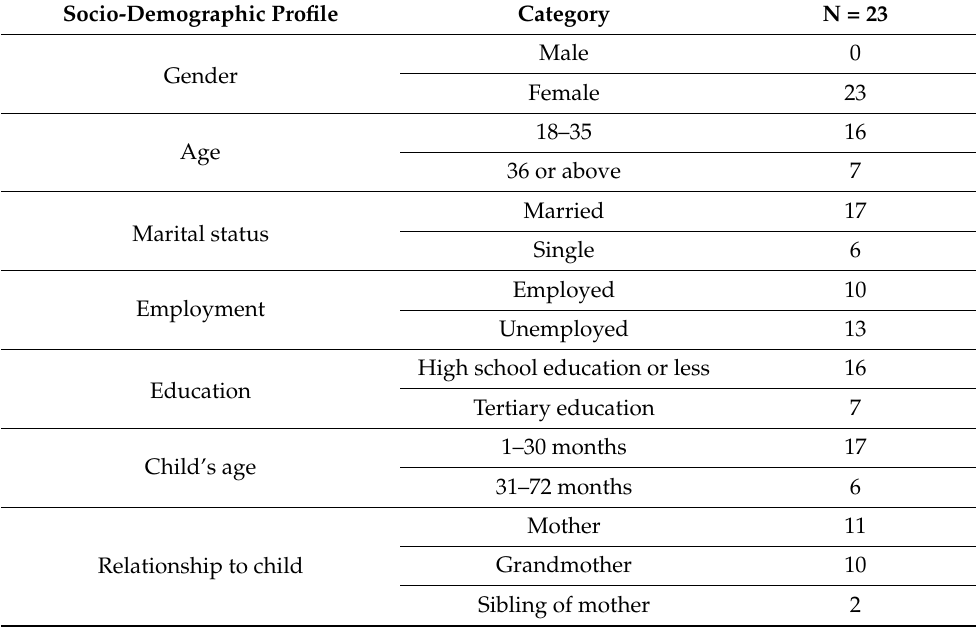
Table 2. Socio-demographic profile of